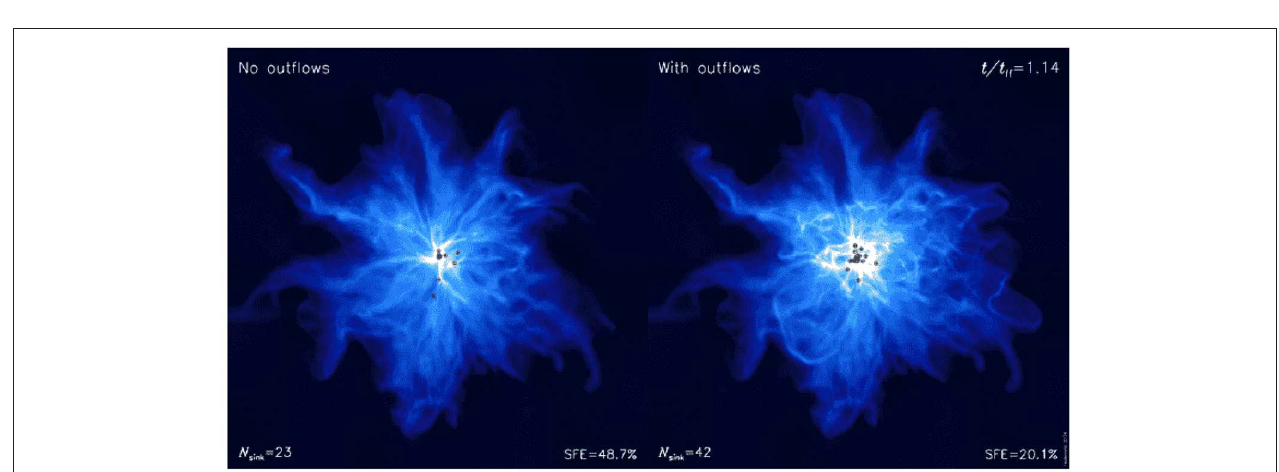
and embedded in clump environments with 6 cl = 1 g cm − 2 . Results for metallicities log ⊙ AAS. (cid:13)